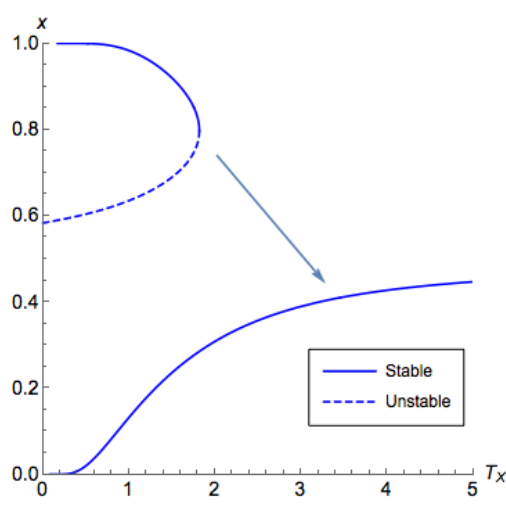
Figure 11. Illustration for Phase 1 in Case (B3), where we keep low T Y but increase T X and then decrease T X back to a small value. In this phase, the equilibrium state moves from the branch where x ∈ ( 0.7,1.0 ) to the principal branch (the branch where x < 0.5).